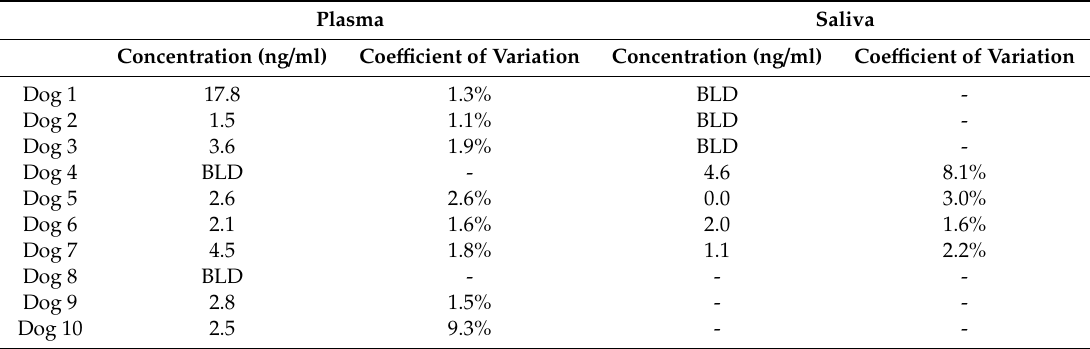
Table 2. Prolactin concentrations in saliva and plasma samples (ng / ml) using a canine prolactin ELISA (enzyme-linked immunosorbent assay) kit. (BLD = below the limit of detection). Plasma